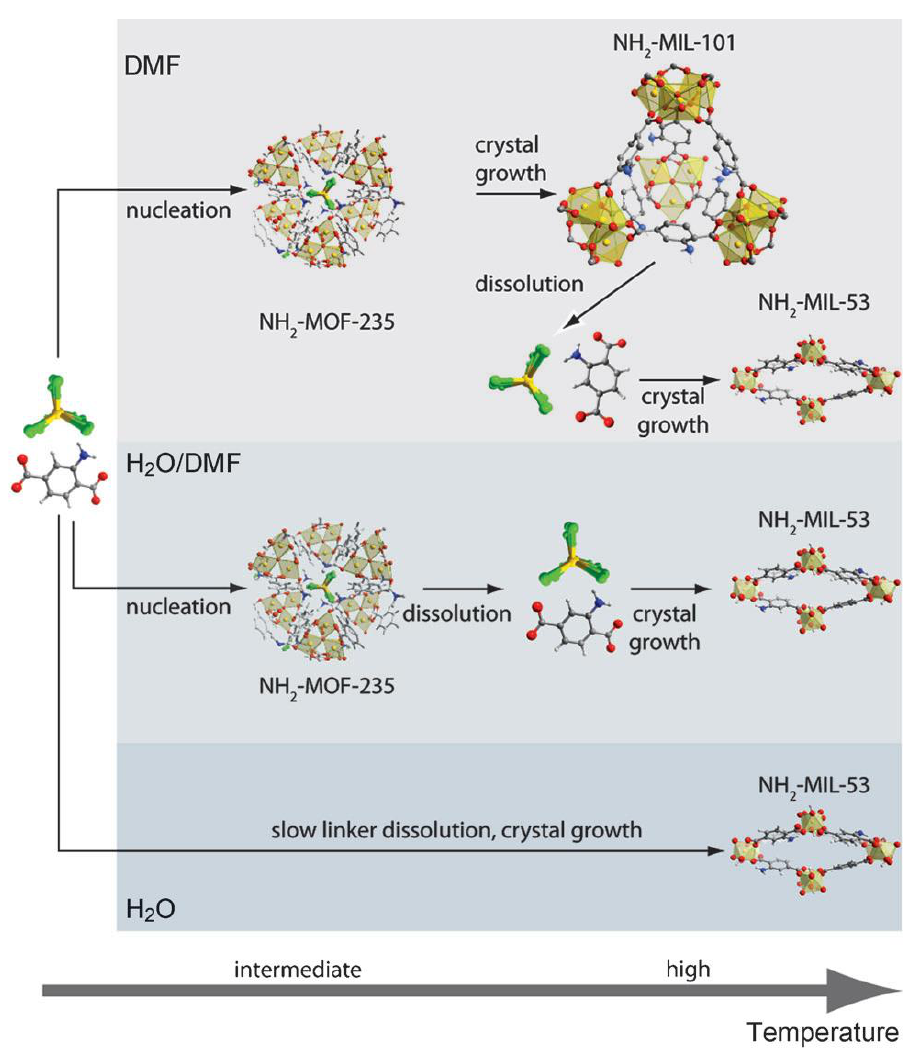
Figure 8. Schematic diagram of the effect of solvent polarity on final structure of MOF. C: gray; H: white; N: blue; O: red; Al: yellow; Cl: green. Reprinted with permission from [44]. Copyright © 2011 WILEY-VCH Verlag GmbH & Co. KGaA,